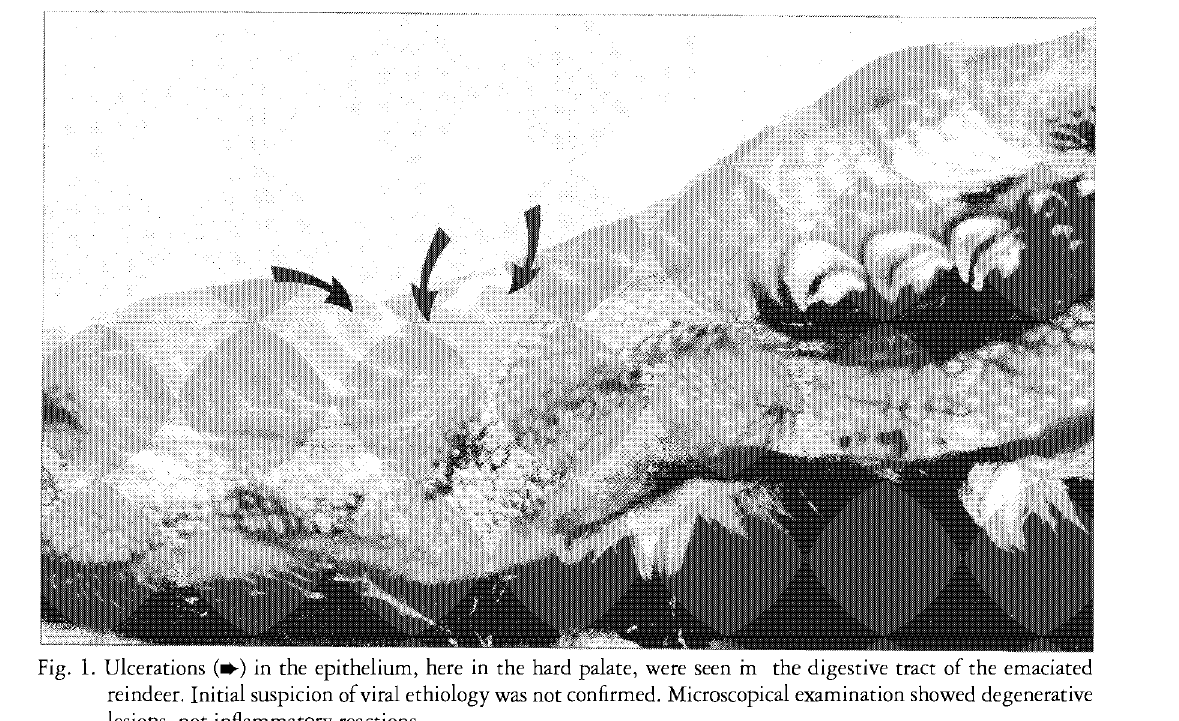
Fig. 1. Ulcerations (#-) in the epithelium, here in the hard palate, were seen m the digestive tract of the emaciated reindeer. Initial suspicion of viral ethiology was not confirmed. Microscopical examination showed degenerative lesions, not inflammatory